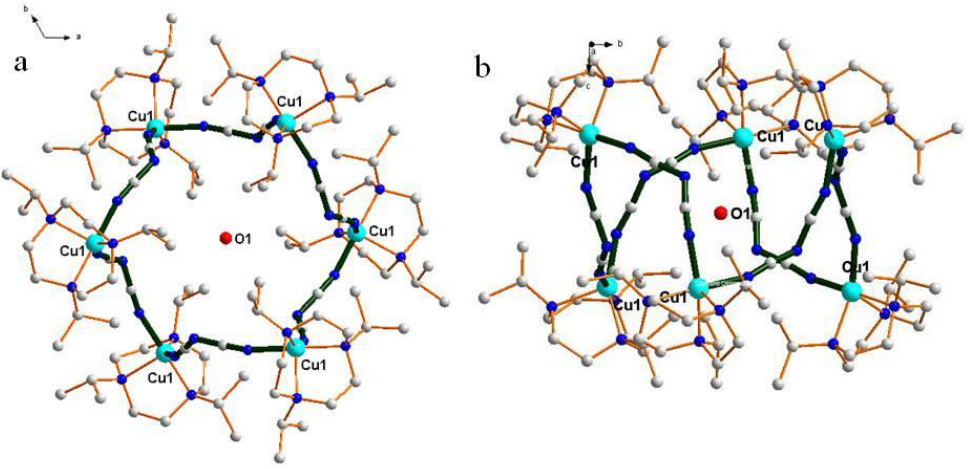
Figure 1. Diagram showing the perspective view of complex 1 with atom labels ( a ) from c axis and ( b ) from a axis.